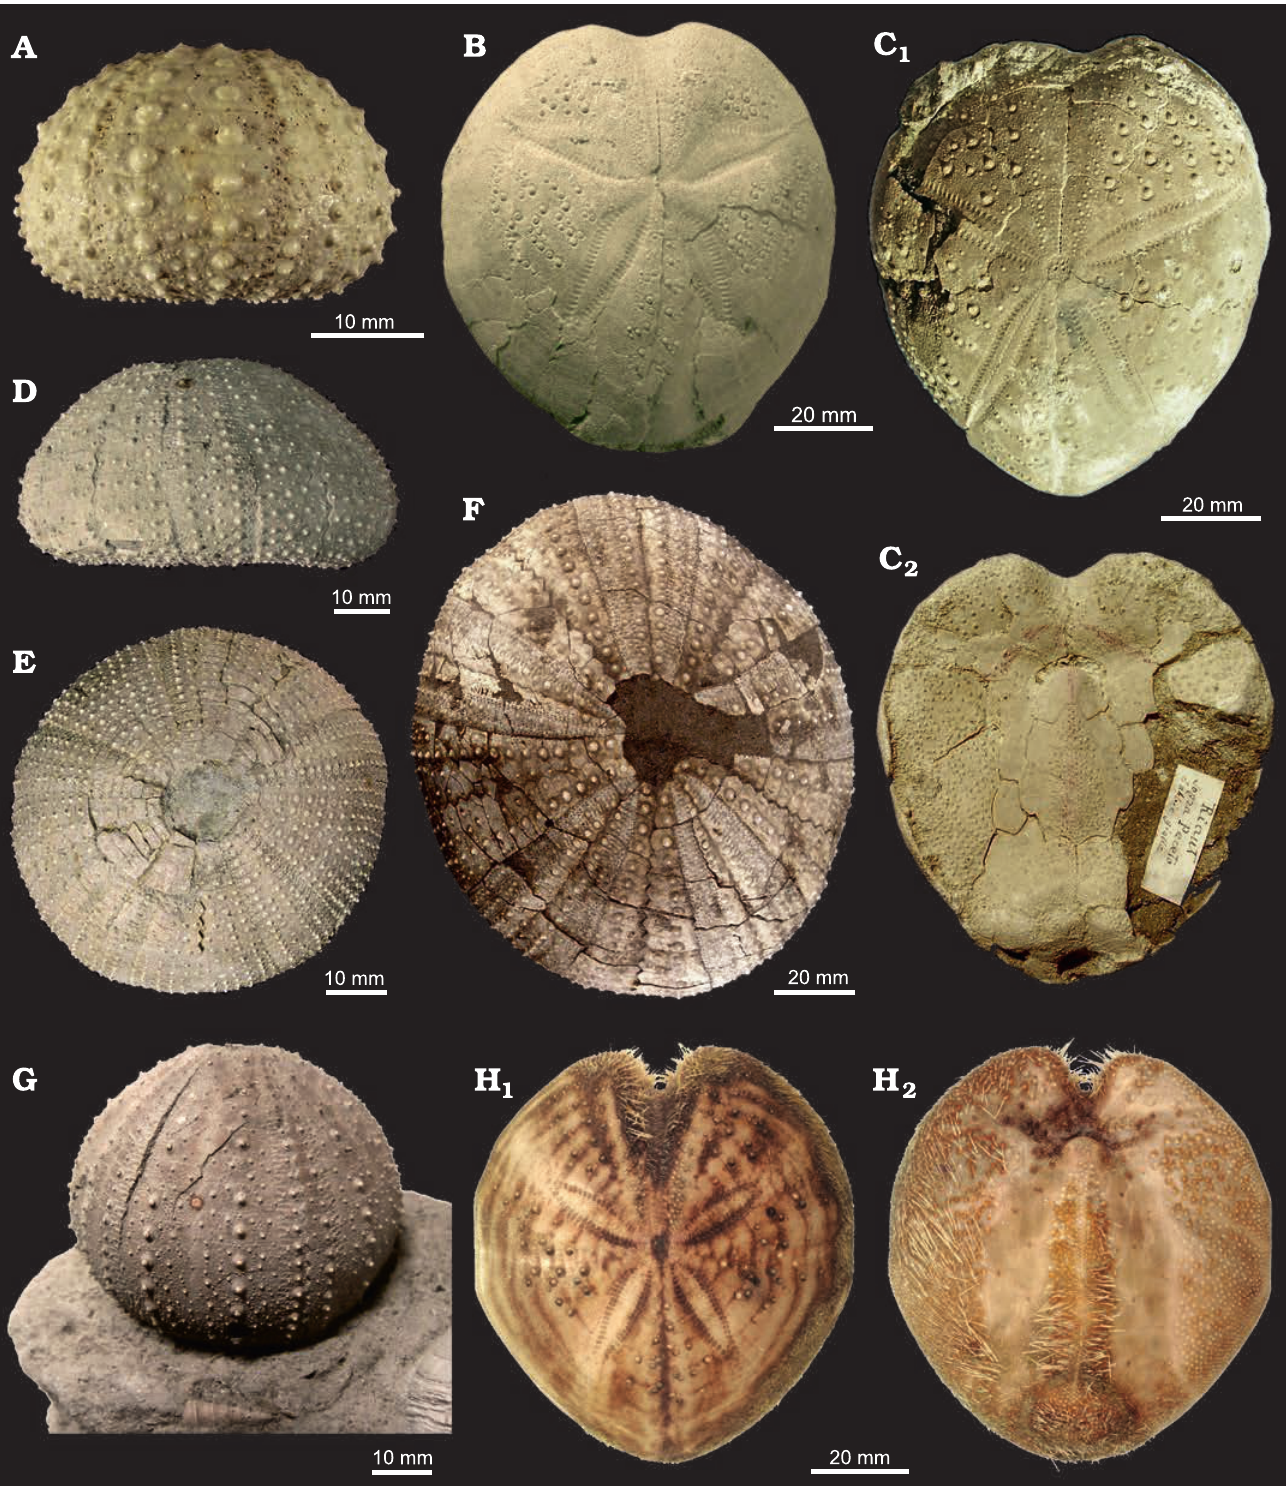
Fig. 4. Rare echinoids from the Mediterranean late Cenozoic to Recent. A . Stirechinus scillae Desor, 1856, MG 1034.10, Early Pleistocene, Contrada Coilare (Messina, Sicily), in lateral view. B . Spatangus purpureus (Müller, 1776), MG 1038.01, Calabrian, Castell’Arquato, Italy, in aboral view. C . Sardo spatangus rovasendai (Airaghi, 1901), MTPL.1246, Piacenzian of Pecetto Piemontese, Italy, in aboral (C 1 ) and oral (C 2 ) views. D . Schizechinus serialis Pomel, 1887, MCS Ss.17, Calabrian, Stirone River, Parma, Italy, in lateral view. E . Schizechinus serialis Pomel, 1887, MG Sz.15, Calabrian, Castell’Arquato, Italy, in aboral view. F . Tripneustes gahardensis (Seunes, 1896), MGUS 2040, late Tortonian–early Messinian, Espera, Spain, in ab- oral view. G . Gracilechinus acutus (Lamarck, 1816), MCS Ga.12 (ex Bussolati collection), Calabrian, Stirone River, Parma, Italy, in lateral view. H . Granopatagus subinermis (Pomel, 1887), MZUF.1359, Recent, off Livorno, Italy, in oral (H 1 ) and aboral (H 2 )